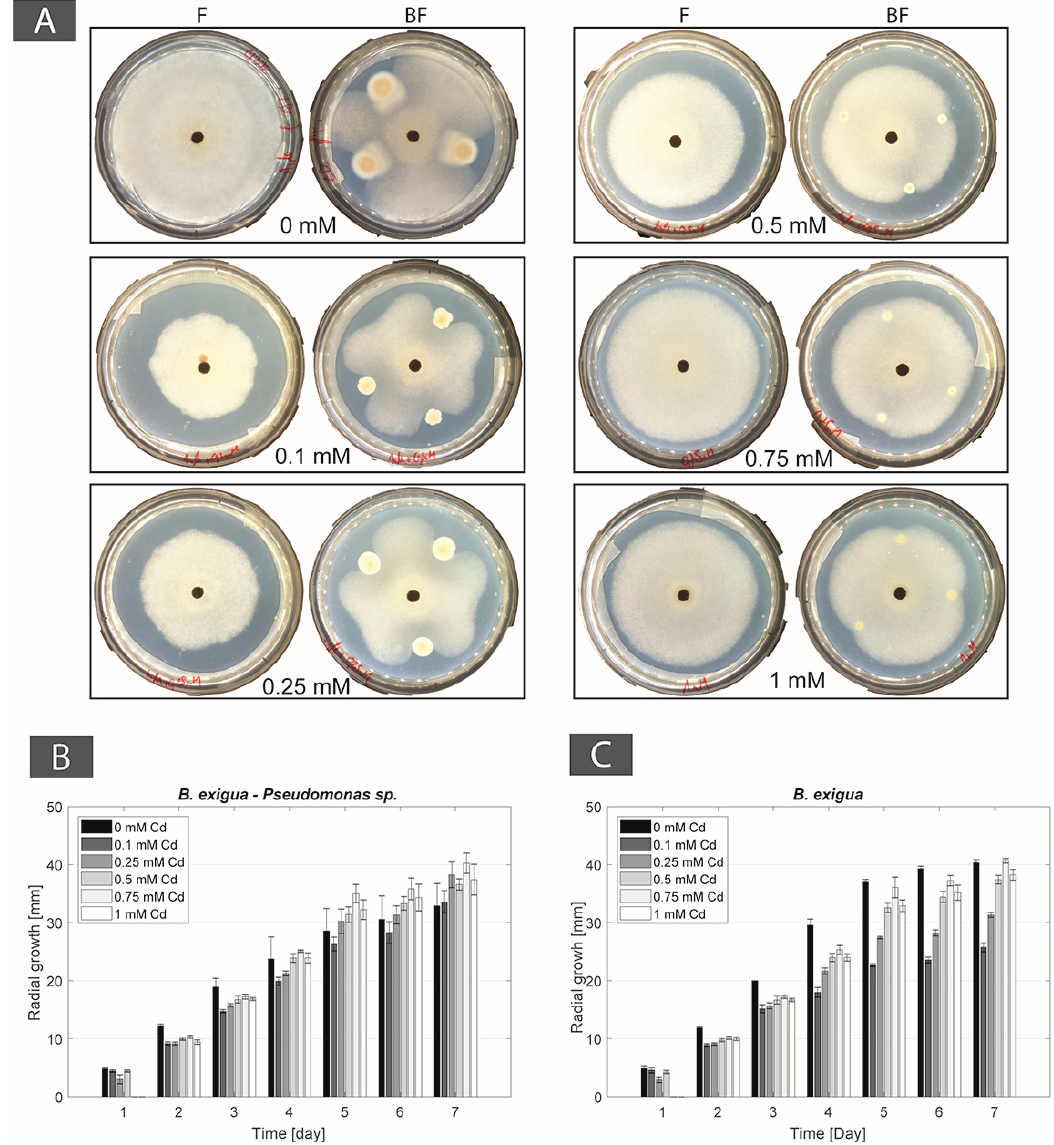
Figure A1. ( A ) Photographs of mono-cultures of Boeremia exigua (F panels) and co-cultures of B. exigua + Pseudomonas sp. (BF panels) in Angle medium (0 mM Cd) and Cd-containing Angle medium (0.1, 0.25, 0.5, 0.75, and 1 mM Cd); ( B ) Radial mycelial growth of B. exigua in co-culture with Pseudomonas sp. in Angle medium (0 mM Cd) and Cd-containing Angle medium (0.5 and 1 mM Cd); ( C ) Radial mycelial growth of B. exigua in mono-culture in Angle medium (0 mM Cd) and Cd-containing Angle medium (0.1, 0.25, 0.5, 0.75, and 1 mM Cd).